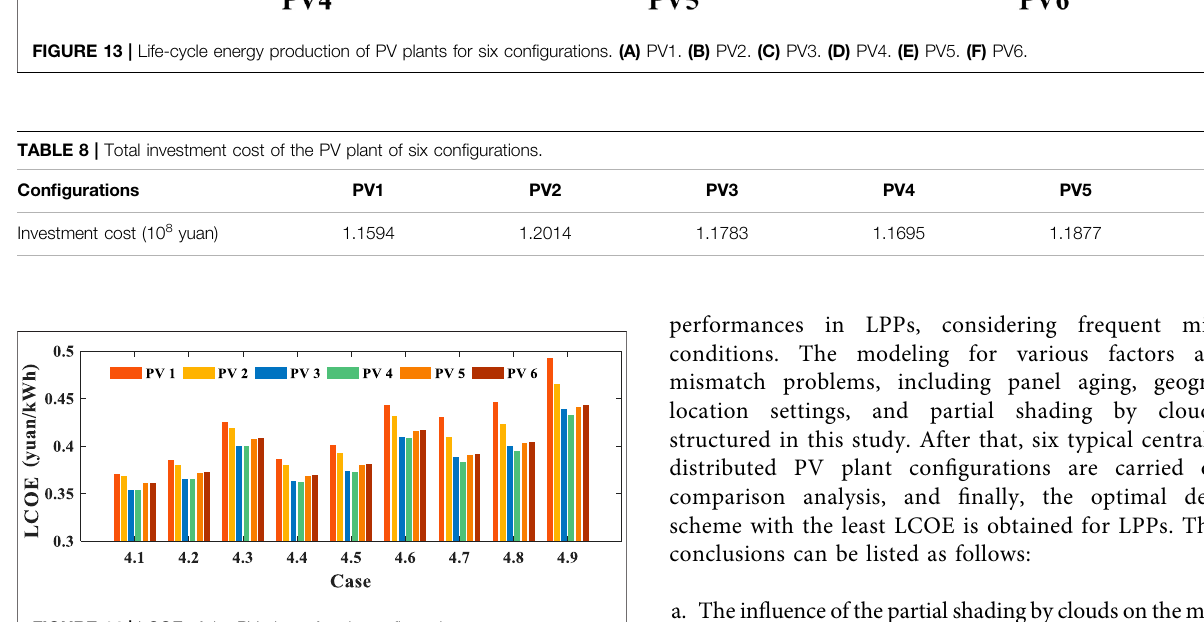
FIGURE 14 | LCOE of the PV plants for six con fi